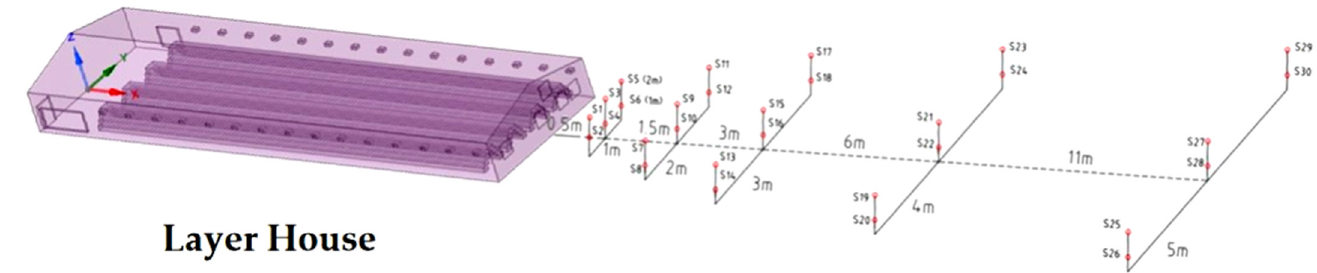
Figure 2. Distribution of measurement points outside the layer house. Thirty sampling locations (S1~S30) with 2 different sampling heights (1 m and 2 m) were deployed perpendicularly downwind of the primary fan. S2 and S6 were 1 m from S4 on either side; S8 and S12 were 2 m from S10 on either side; S14 and S18 were 3 m from S16 on either side; S20 and S24 were 4 m from S22 on either side; and S26 and S30 were 5 m from S28 on either side. The points were parallel to the layer house.